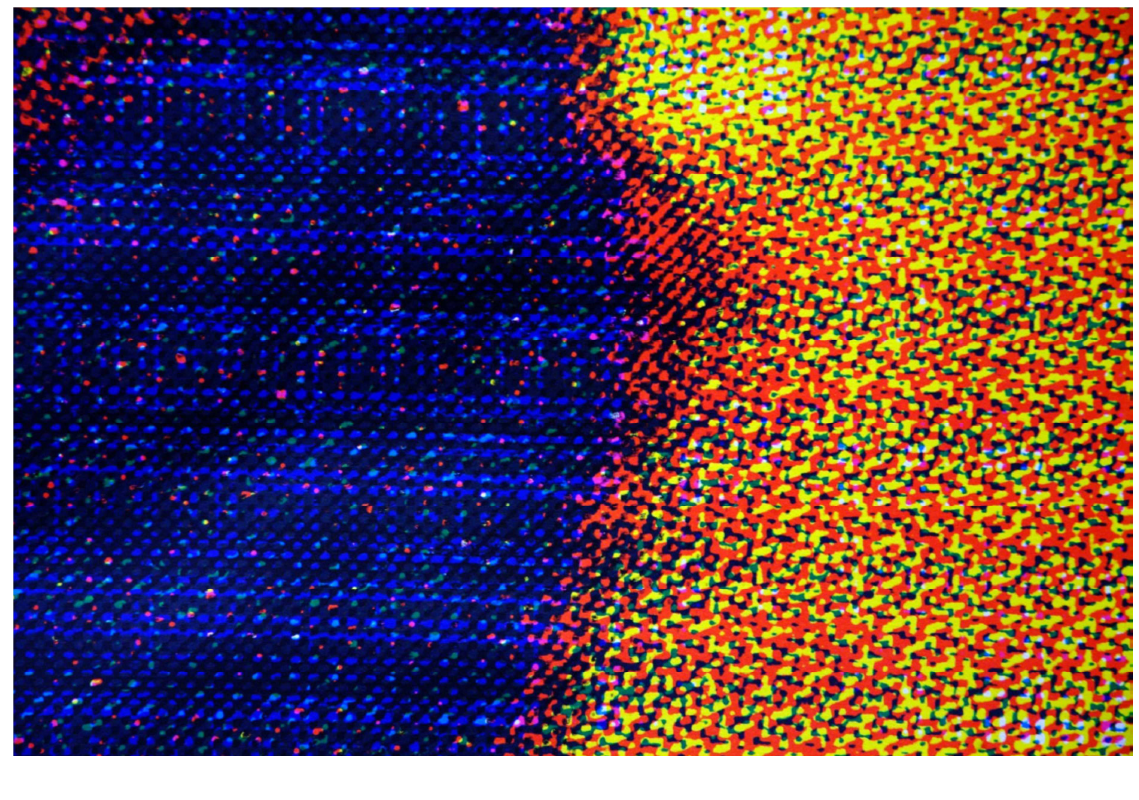
Imogen Tyler and Lisa Baraitser, Private View, Public Birth: Making Feminist Sense of the New Visual Culture of Childbirth Studies in the Maternal , 5 (2), 2013, www.mamsie.bbk.ac.uk